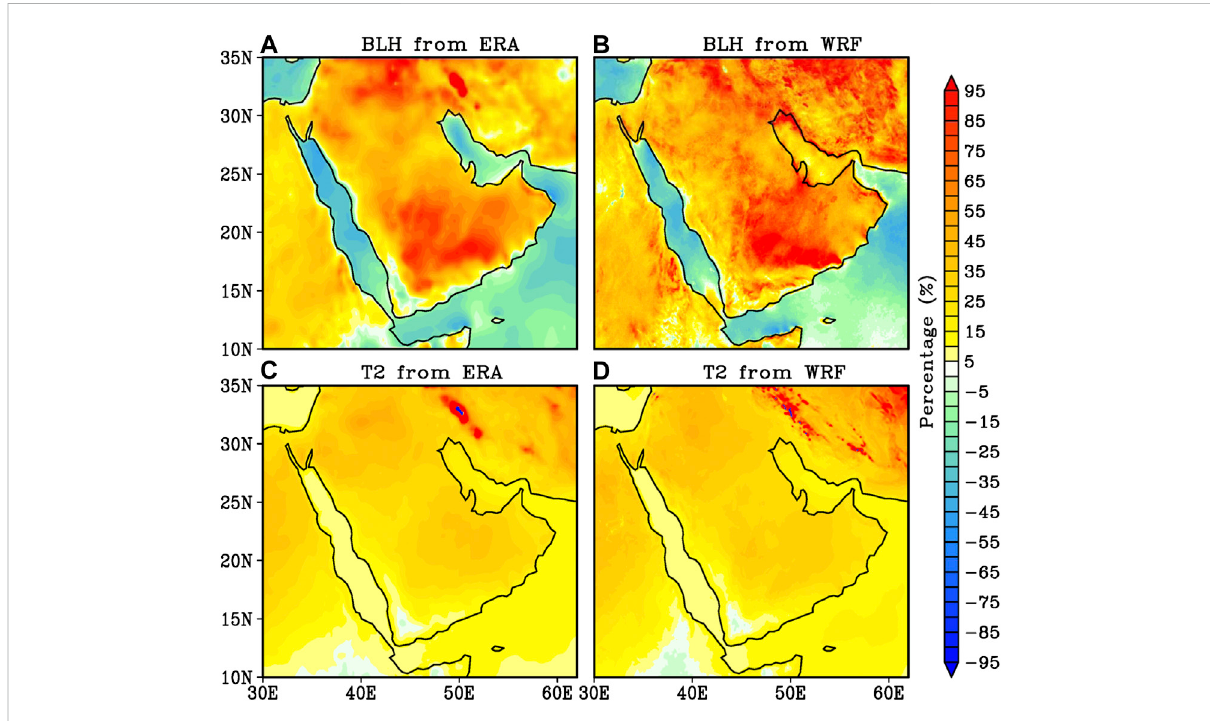
FIGURE 9 PercentagedifferencesbetweenDLD andPLD periodsfor BLH, and 2m Temperature from ERA-5reanalysis (A, C) andWRF-chem simulations (B,D)